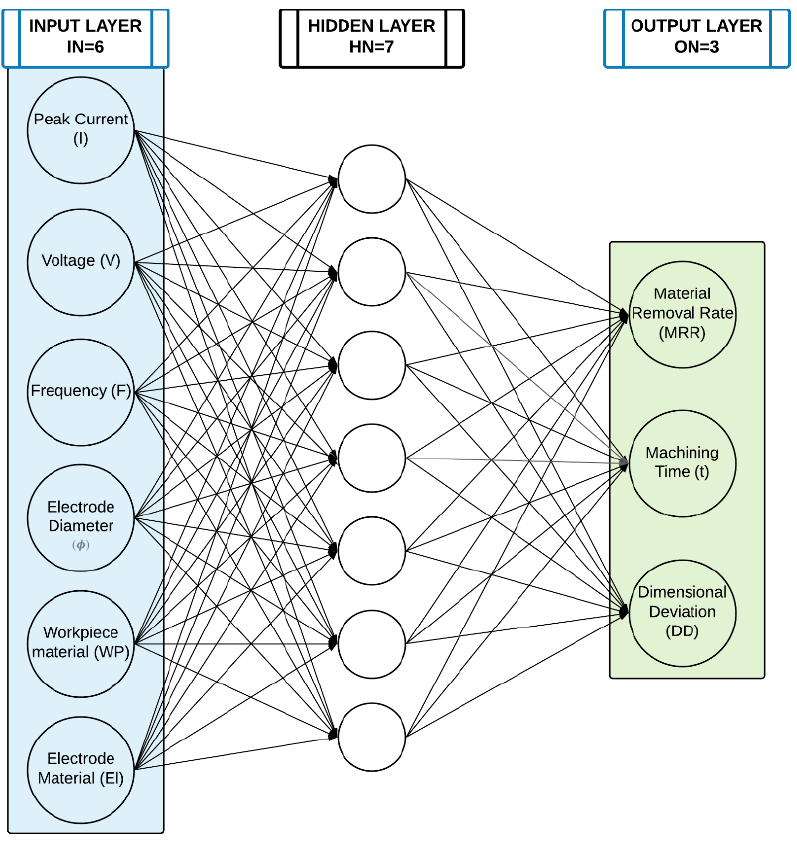
Figure 1. ANN Figure 1. ANN structure.